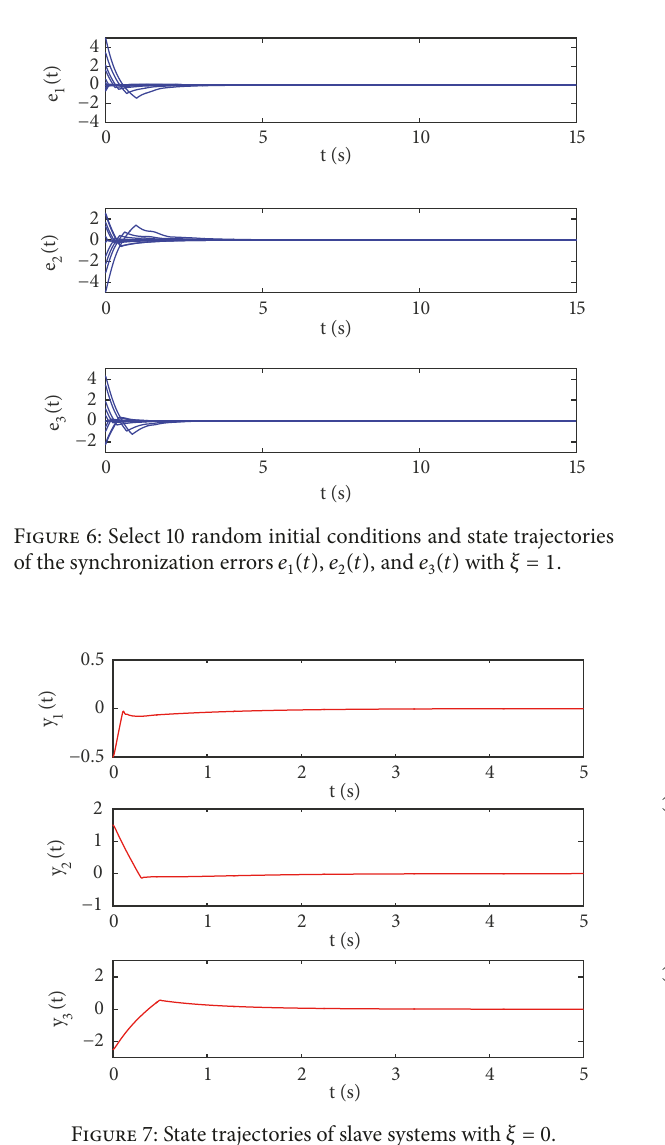
Figure 7: State trajectories of slave systems with 𝜉 = 0.